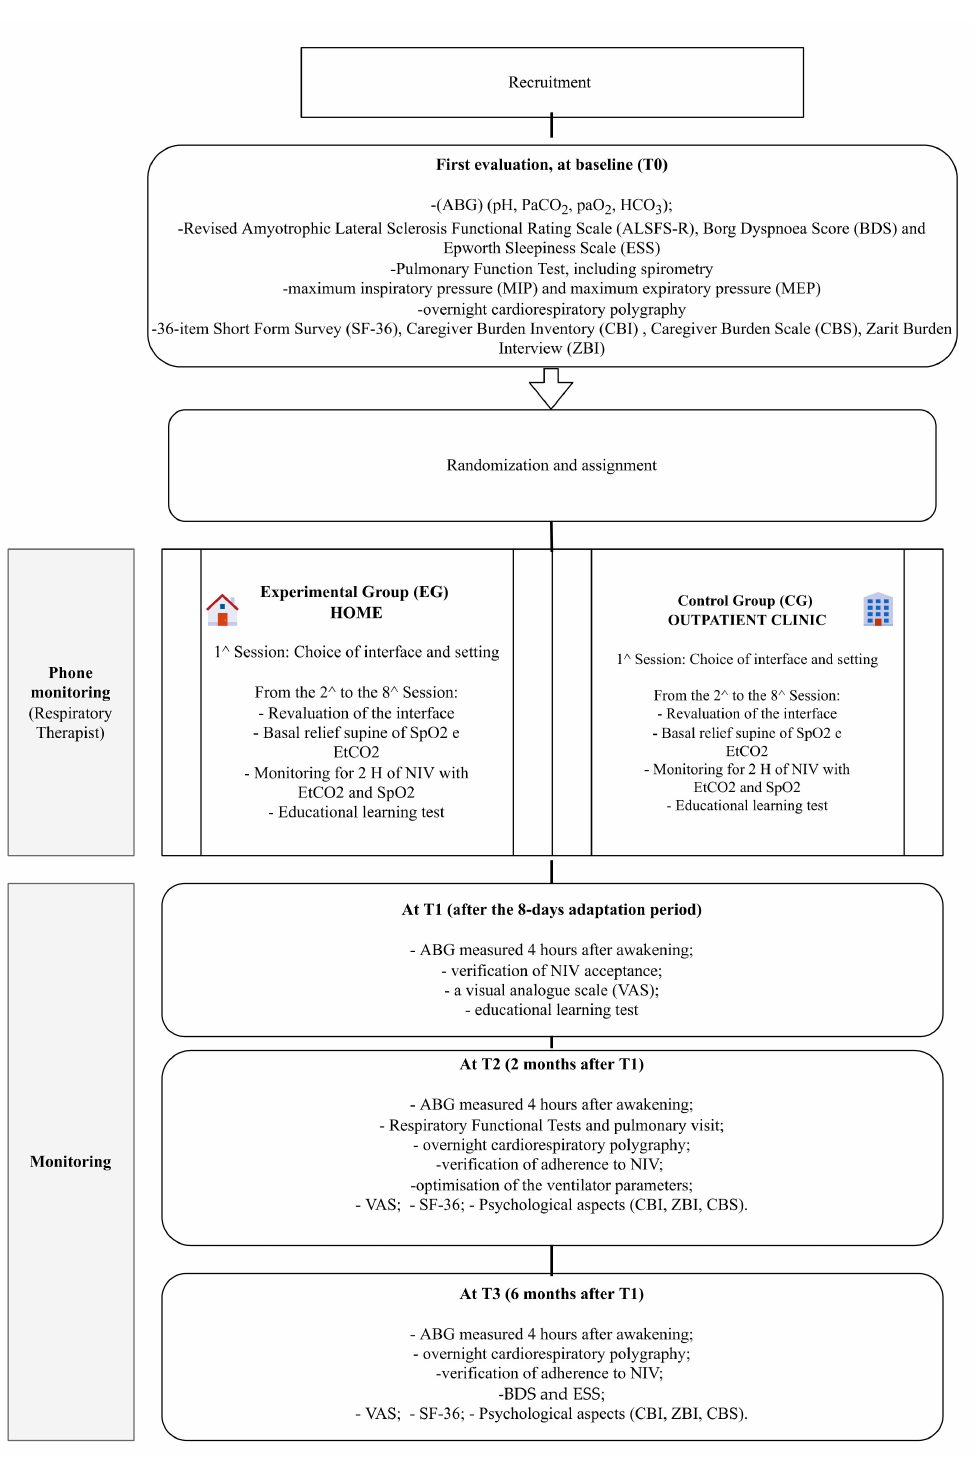
Figure 1. Scheme of the implementation